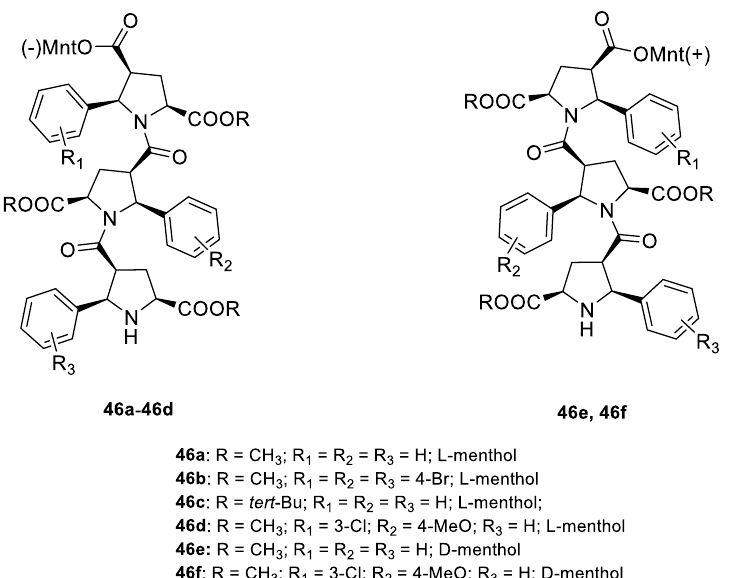
Figure 20. Homochiral 3-PCA trimers with monoterpene menthol derivatives. A series of N -acylhydrazones attached to the C13 of doxorubicin ( 47 ) (Figure 21) were tested in vitro for eligibility as anticancer agents [84]. The acyl residues were derived from ( − )-menthyl esters and incorporated via differentially sized alkyl spacers. These deriva- tives were assayed for cytotoxicity in cell lines from human cancers that are typically treated with doxorubicin, specifically leukemia, melanoma, breast carcinoma and cervical carcinoma (Table 1). The tested N -acylhydrazones of doxorubicin with an added ( − )-men- thol moiety might complement or even surpass the properties of the parent drug in terms of cytotoxic efficacy, cell specificity, breach of multidrug resistance, mechanism of apop- tosis and a combination of molecular targets. The (menthoxycarbonyl)undecanoyl hydra- zone compound 47d was twice as active as doxorubicin against multidrug-resistant KB- V1/Vbl cervical carcinoma and 518A2 melanoma cells. Compound 47d was also more ef- fective in KB-V1 cervical carcinoma and MCF-7 breast cancer cell lines.